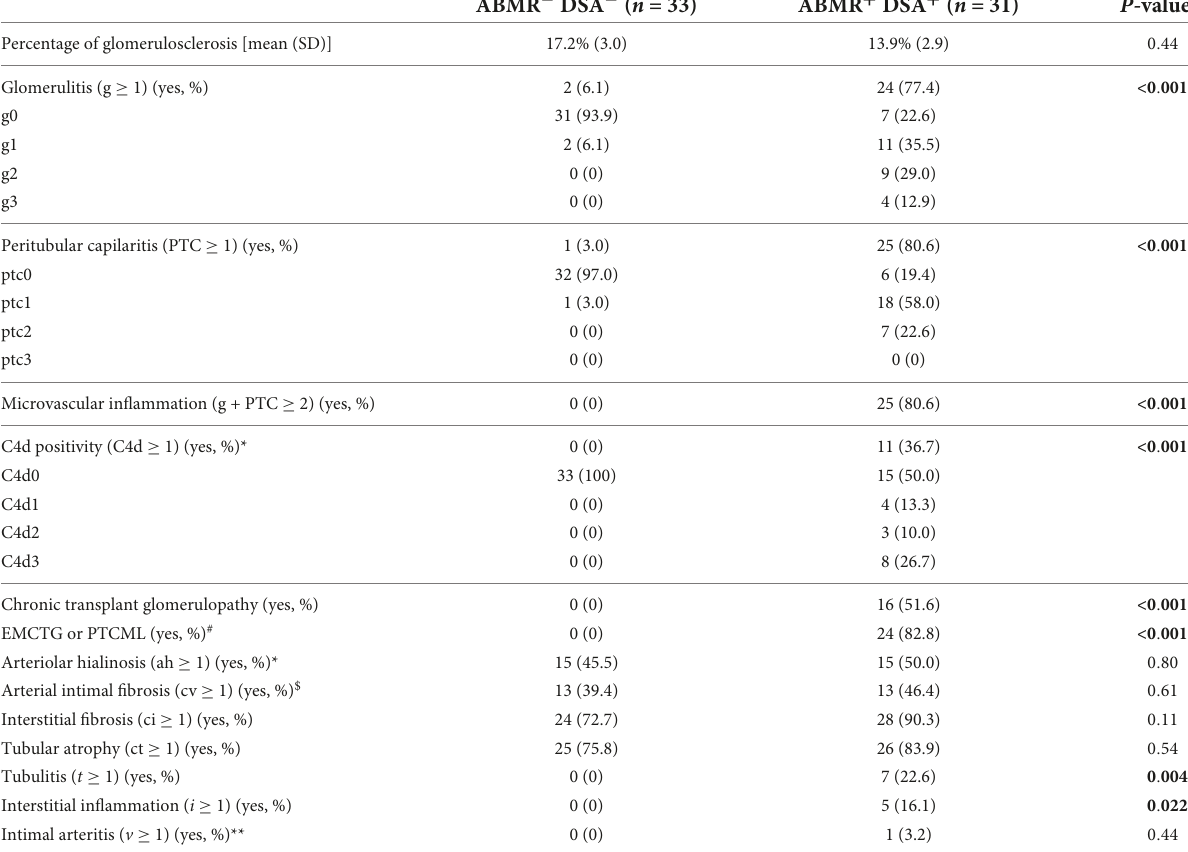
TABLE 2 Comparison of the histopathologic lesions in the biopsy of patients with ABMR and HLA-DSA (ABMR + DSA + ) and without ABMR and HLA-DSA (ABMR − DSA − ). ABMR − DSA − ( n = 33) ABMR + DSA + ( n = 31) P -value Percentage of glomerulosclerosis [mean (SD)]